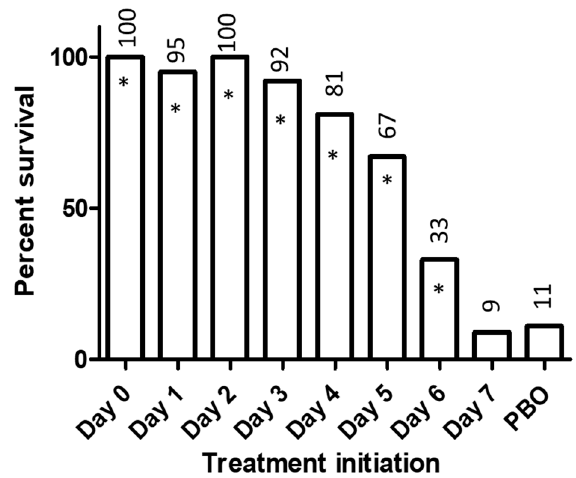
Figure 2. Survival by day of treatment initiation in the intranasal inoculation mousepox model. Data were pooled across studies and include different mouse strains, viral inoculum levels, and BCV dosage regimens. Data included for Studies CMX001-SLU-005, -006, -007, -008, -009, -011, -012, -013, -014, and CMX001-VIR-102 (initial BCV doses of 10 mg/kg to 30 mg/kg or placebo, single ± maintenance doses, treatment initiation Day 0 to Day 7, A Strain (A/NCR, A/J), SKH-1, C57Bl/6, and BALB/c mice). Individual studies included either male or female mice. All SKH-1, C57Bl/6, and BALB/c mice represented in the figure were female ( N = 132, 110, and 55, respectively). A Strain mice included both males and females ( N = 266 and 179, respectively). The numbers above the bars indicate the percentage survival. The number of animals for each treatment initiation day: Day 0 = 35, Day 1 = 20, Day 2 = 30, Day 3 = 75, Day 4 = 115, Day 5 = 144, Day 6 = 168, Day 7 = 44, PBO = 111. * Two-sided Fisher’s exact test, p < 0.0001 vs. placebo. No adjustments were made for multiple comparisons. These results have been previously published [17–19], with the exception of the BALB/c results (Study CMX001-VIR-102).